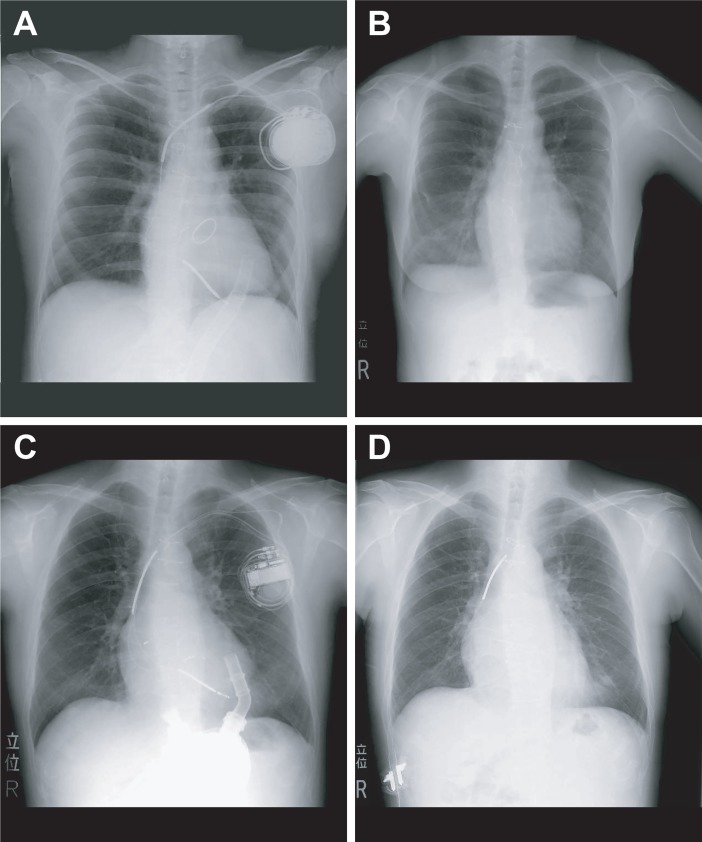
The patients with the retained fragment in superior vena cava after OHT.(A) Chest X-ray of a patient who had an ICD with dual coil shock lead before OHT, (B) Lead fragment from a dual coil defibrillator in the patient shown in (A), as observed in the subclavian vein after OHT. (C) Implantation of a CRTD with dual coil shock lead. (D) Retained distal shock coil in superior vena cava after OHT.